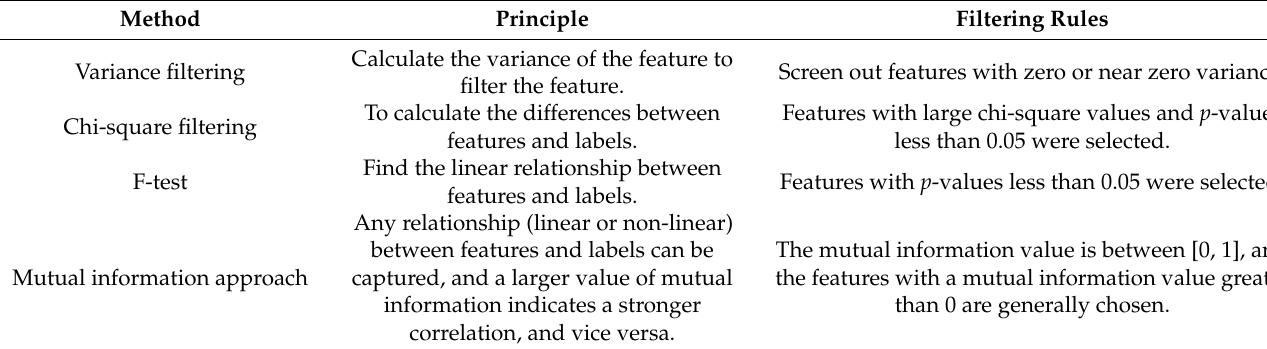
Table 2 outlines the principles and filtering rules for each of the four techniques. Table 2. Summary of common filtering